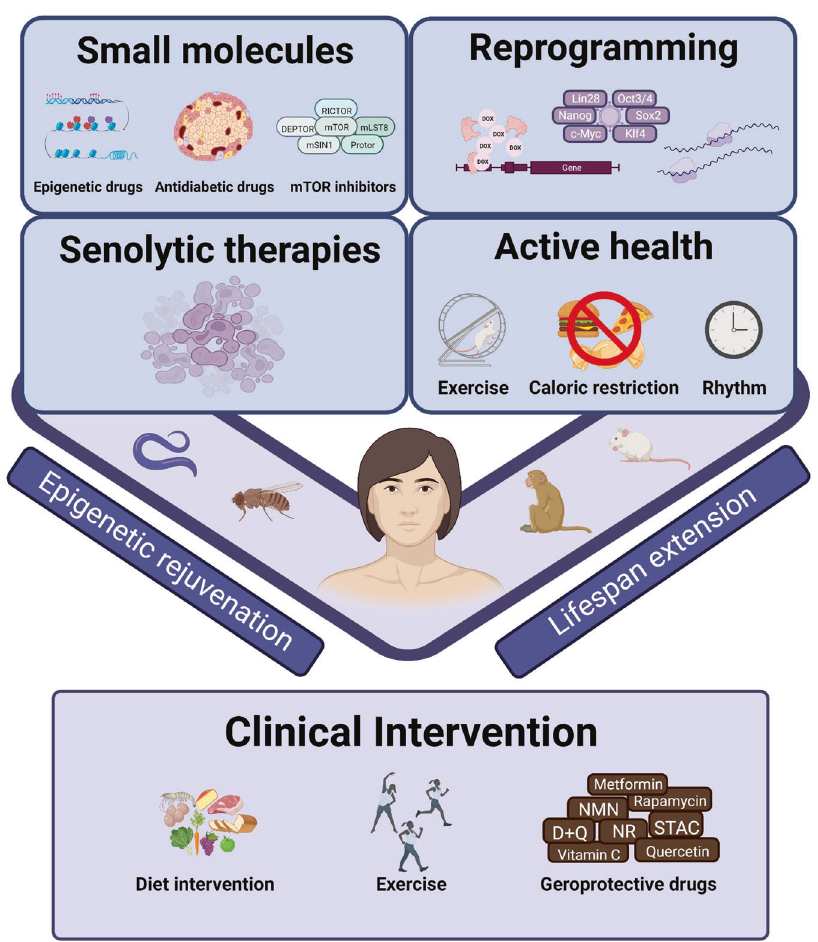
Fig. 7 The intervention of aging. Existing intervention strategies aim to alleviate aging in various